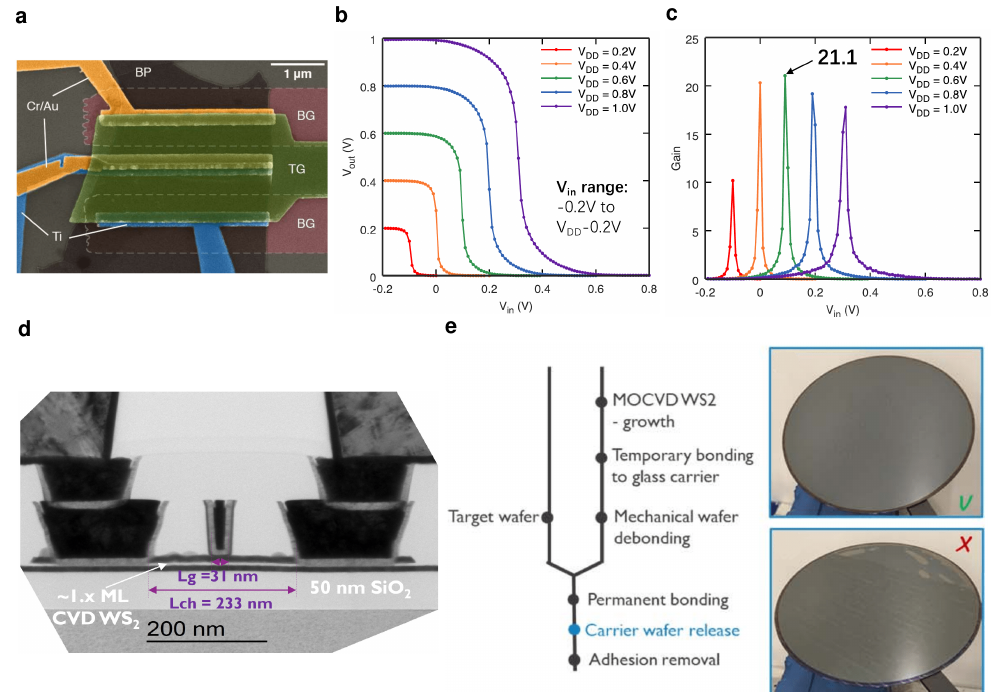
Figure 5. ( a ) False–colored SEM image of black phosphorus (BP) FETs with Cr/Au contacts for the p-type FET (top) and Ti contacts for the n-type FET (bottom). A 4nm thick Al 2 O 3 layer serves as both the top gate (TG) and the back gate (BG) gate insulator and the two separate BGs are used to adjust the threshold voltages of p- and n-type FET. These two FETs form an inverter with the input connected to the TG and the output to the shorted Ti and Au contacts at the center. ( b ) Voltage transfer characteristics of the BP/Al 2 O 3 inverter with local back gates at different supply voltages V DD . ( c ) Gain of the BP/Al 2 O 3 inverter at different V DD , with the highest gain of 21.1 observed for V DD = 0.6V. ( a – c ) reproduced with permission from P. Wu et al., DRC 2018; published by the IEEE [106]. ( d ) TEM image of double-gated WS 2 FETs fabricated in a 300mm pilot line, which use HfO 2 as a top gate and a HfO 2 /SiO 2 stack as a back gate oxide. The device has a short top gate length of 31 nm, a total channel length of 233 nm and trench side contacts to the few-layer WS 2 channel. Reproduced with permission from Z. Ahmed et al., IEDM 2020, published by the IEEE [25]. ( e ) Schematic of the transfer process for WS 2 grown on a 300 mm wafer. The MOCVD growth process is performed at a high temperature of above 900 °C, then the wafer is bonded to a glass carrier, mechanically debonded from the growth substrate before it is permanently bonded to the target wafer. On the right side, images show that the transfer can be uniform (top) and non-uniform (bottom) indicating a need for further process improvement. Reproduced with permission from I. Asselberghs et al., IEDM 2020; published by the IEEE